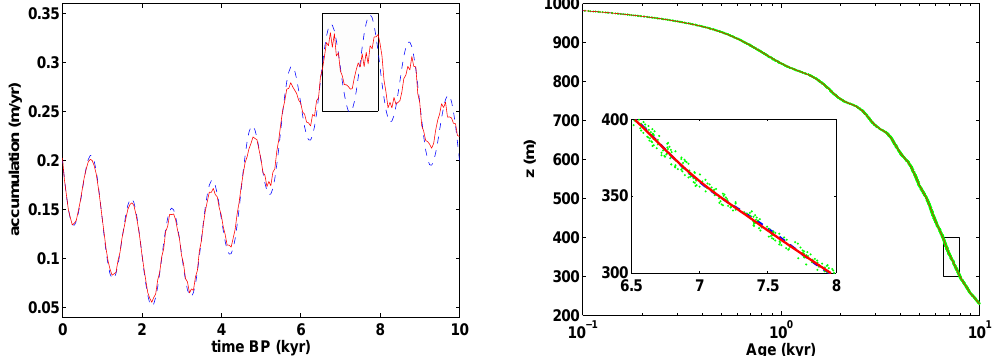
Figure 1. Recovered accumulation (red, left panel) and age–depth distribution (red, right panel) from age–depth synthetic data (green, right panel). The synthetic age–depth distribution was obtained by adding 1% uniform noise to the reference solution (blue, right panel) derived from the reference accumulation record (blue, left panel). The inset in the right panel provides a close-up of the age–depth profile in an area that is highlighted both in the accumulation record and in the age–depth distribution.